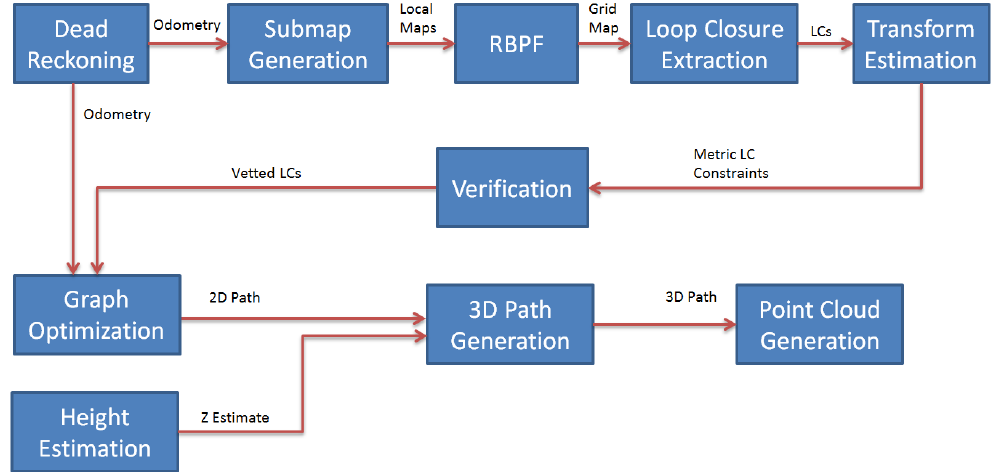
Block diagram of the algorithms used for localizing an ambulatory backpack